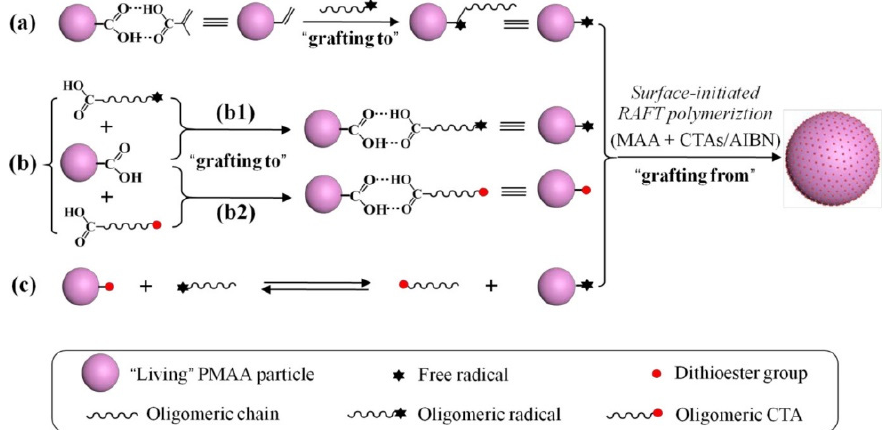
Figure 7. Three Proposed Particle Growth Mechanism in RAFTPP of MAA. ( a ) By capturing oligomeric radicals with particle surface vinyl groups; ( b ) By adsorbing oligomeric polymer chains from the continuous phase; ( c ) By the surface-initiated RAFT polymerization through the surface dithioester groups. Reprinted with permission from Ref. [48]. Copyright 2019 American Chemical Society.